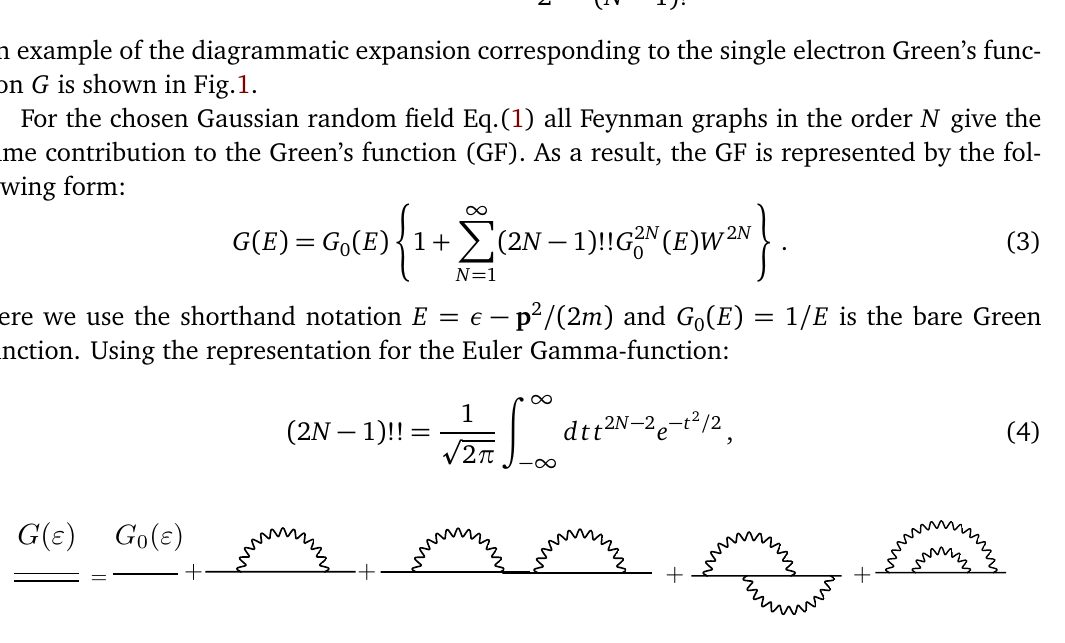
Figure 1: Diagrammatic expansion for the Green’s function. The double line corre- sponds to bold Green’s function. The single lines denote bare Green’s functions. The wavy lines stand for the correlator of the Gaussian classical random